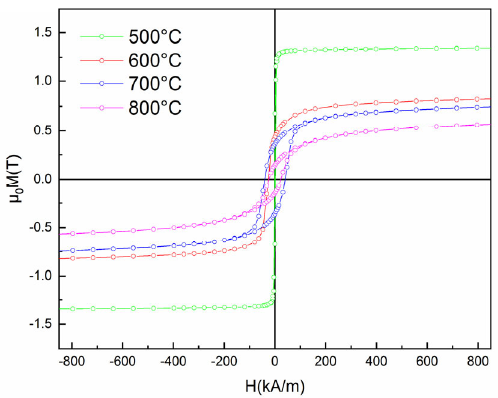
Figure 10. The hysteresis loops for the samples annealed at various temperatures. The curve for the sample annealed at 500 °C is typical for soft magnetic materials, with virtually no coercivity, a fast approach to saturation, and high saturation magnetization (cca. 1.3 T), but as the annealing temperature goes up, the saturation magnetization diminishes due to the continuous increase of the grain size and the steady increase of the paramagnetic contribution observed in the Mössbauer spectra. Most interesting is that a magnetic hardening occurs in the annealed sample, with non ‐ negligible coercive fields recorded for the annealed samples. The coercivity reaches a maximum for the sample annealed at 700 °C. All the values of the coercive fields and of the saturation magnetization recorded in the hysteresis loops are plotted as a function of annealing temperature in Figure 11. It can be observed that the coercivity reaches indeed a maximum for the annealing at 700 °C which is now confirmed to be the optimal annealing temperature for improving the magnetic properties of the alloy. As for the saturation magnetization, these values decrease slowly with an increase in the annealing temperature, from around 1.4 T for 500 °C annealing down to about 0.5 T for the 800 °C annealing. Such behavior of the coercivity is explainable by the phase evolution of the samples during annealing. As the metastable as ‐ cast state is magnetically soft, upon annealing, the crystals nucleate and grow in a tridimensional model. The formed nanograins are initially monodomains, for intermediate stages of annealing 500 °C–600 °C. After annealing at 700 °C, the average grain size is only 16 nm. This refined microstructure is formed of grains from two magnetic phases and due to various reversal